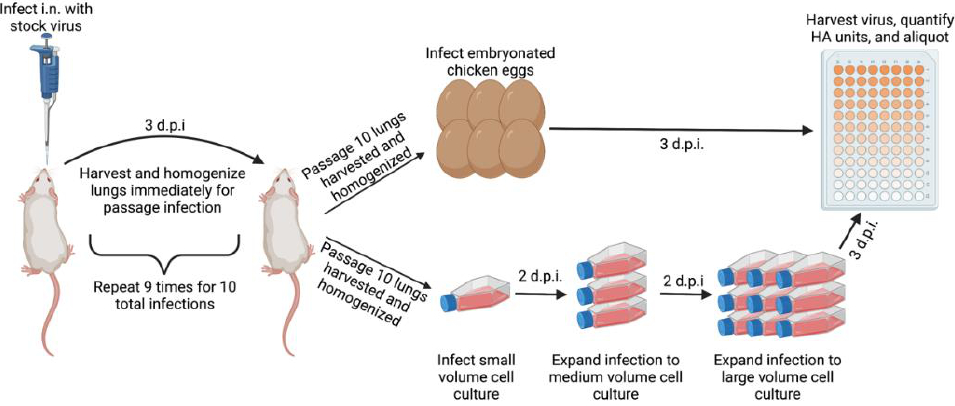
Figure 1. Schematic depicting mouse-passaging procedure. Passage 1 mice were infected i.n. with 20 µL of stock virus. In 3 d.p.i., the lungs were harvested and homogenized before pooling of the lung lysate. Passage 2 mice were then infected with 20 µL of pooled lung lysate and the procedure was repeated up to passage 10. After homogenizing passage 10 lungs, the lysate was diluted and used to infect either embryonated chicken eggs or MDCK-London cells. Infected embryonated eggs were incubated at 33 °C for 72 h before being moved to 4 °C overnight. Allantoic fluid was harvested the next day. An amount of 25 cm 2 infected MDCK-London cells were incubated at 33 ◦ C for 48 h before clarified supernatant was used to infect a 75 cm 2 flask. The 75 cm 2 flask was incubated for 48 h at 33 ◦ C before expansion into a 225 cm 2 flask. Finally, 225 cm 2 MDCK-London cells were incubated at 33 ◦ C for 72 h before harvesting virus from supernatant. Schematic created in